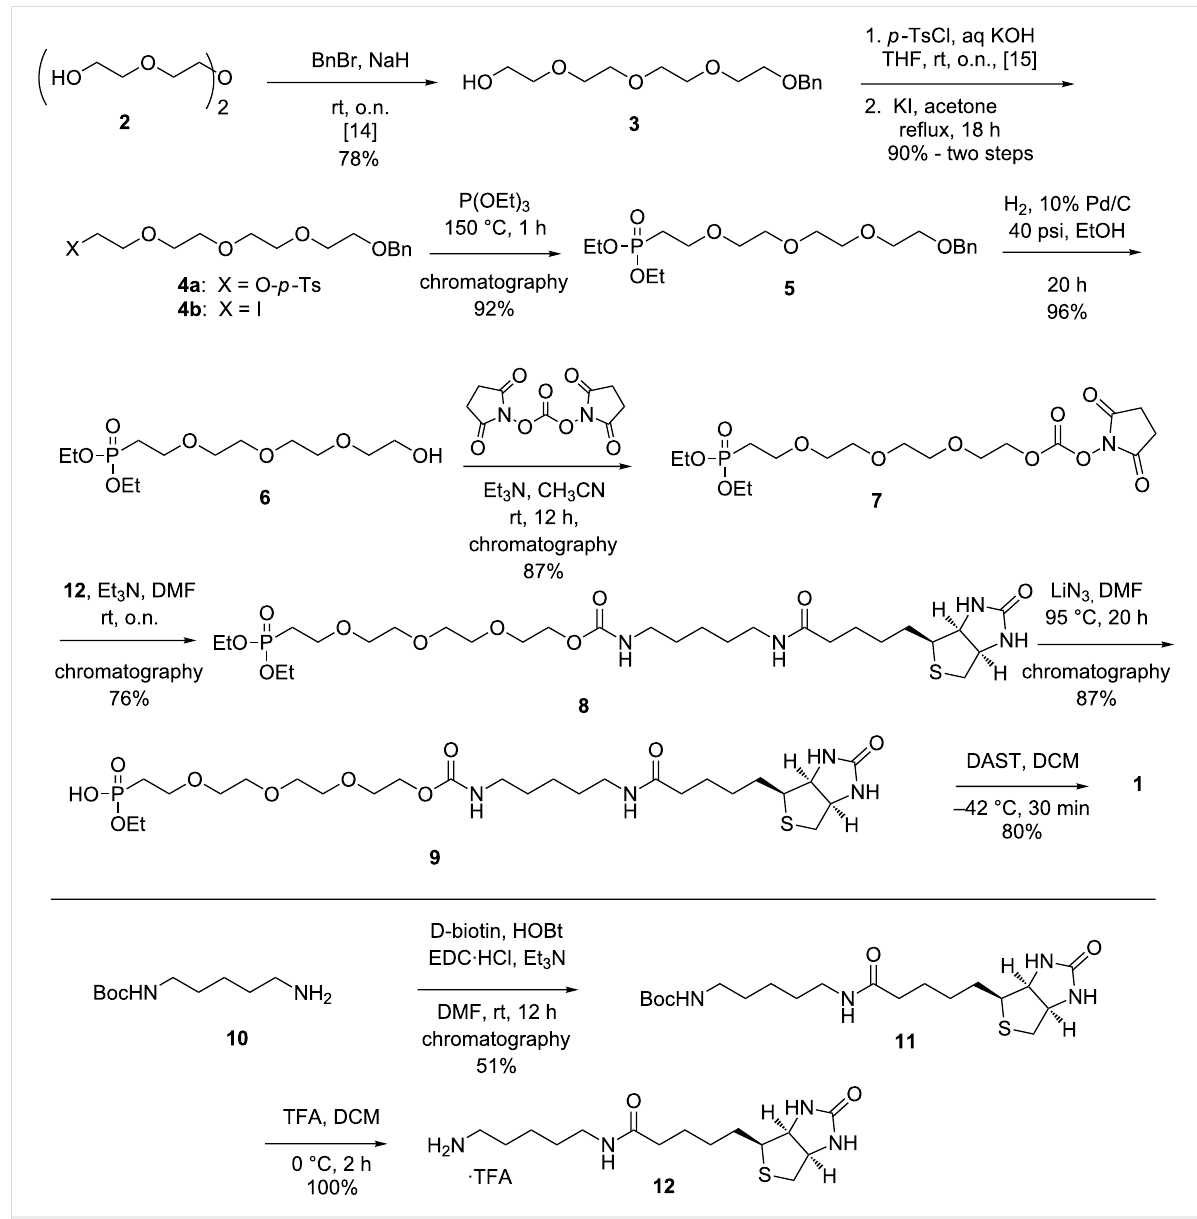
Scheme 1: Synthetic scheme to FP–PEG–biotin probe 1